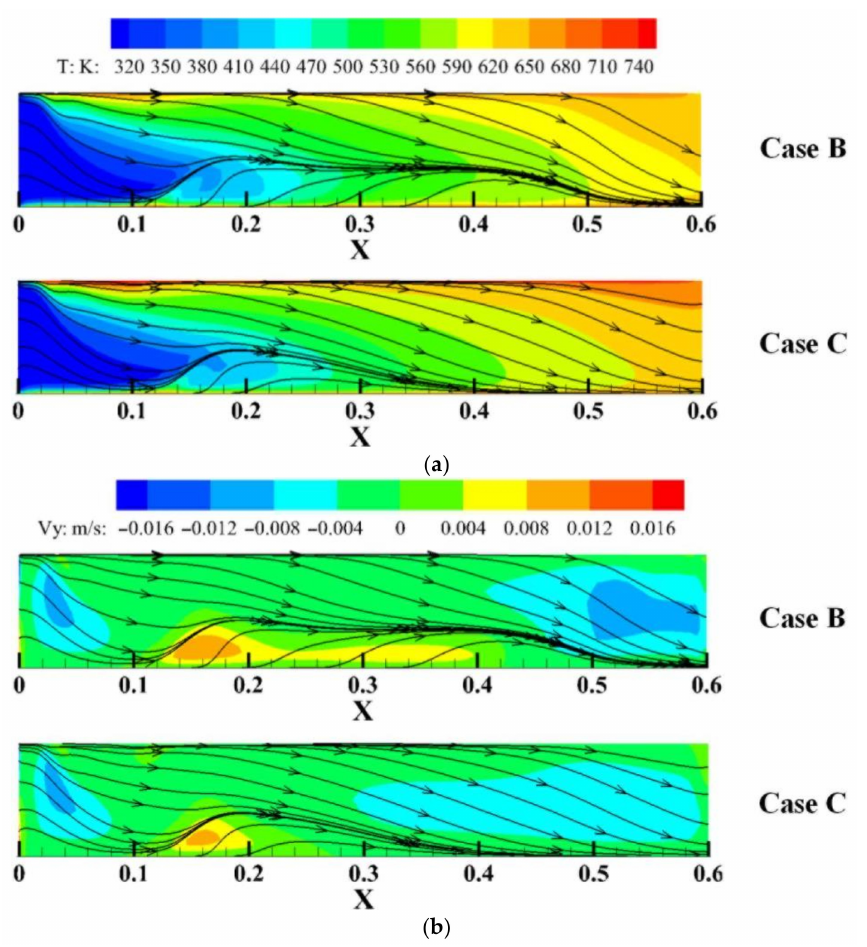
Figure 15. Two-dimensional streamlines at Z = 2 mm visualized under a uniform magnitude: ( a ) temperature; ( b )